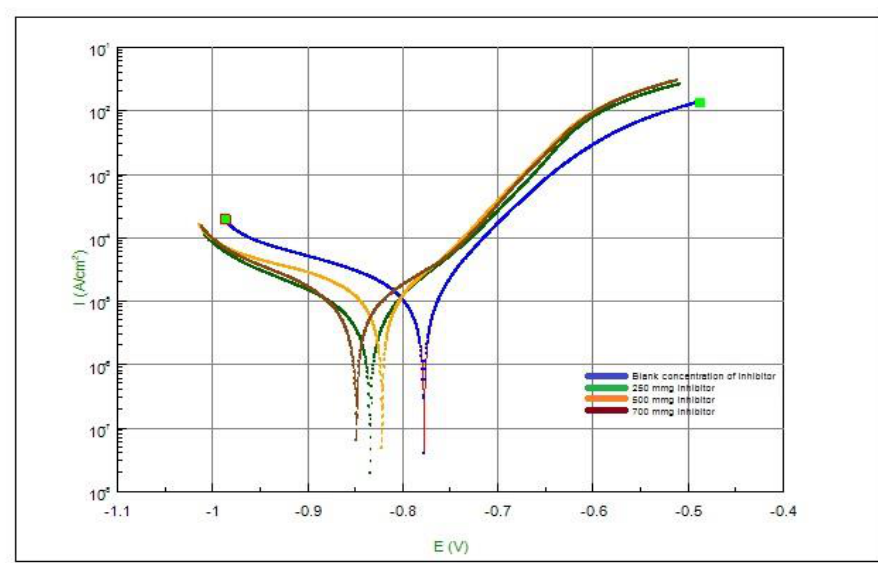
Fig. 6. Variation of inhibitor concentration on current density and voltage at 55